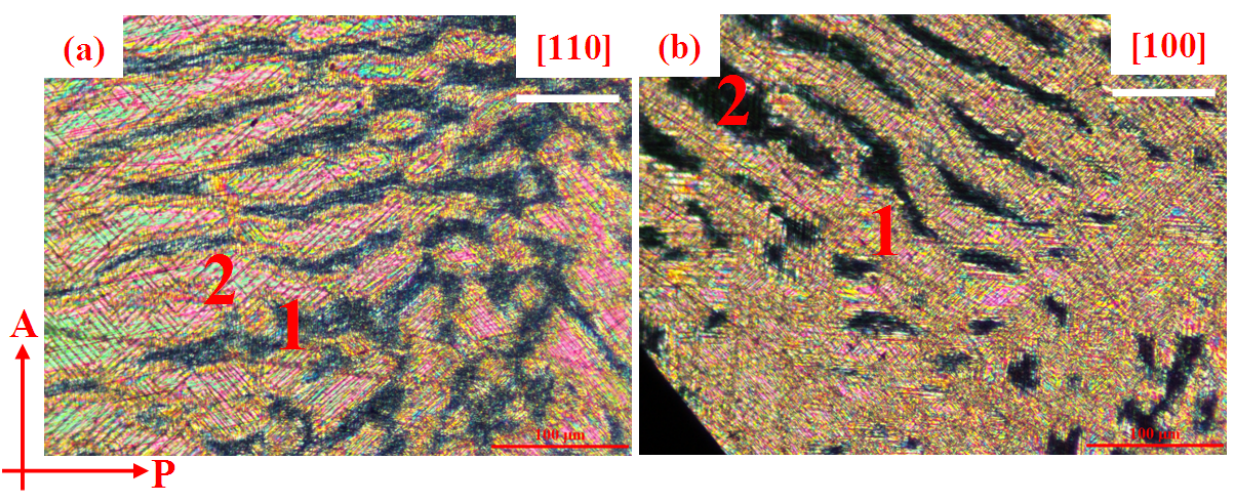
Figure 6. Domain structure of [001]-oriented KNN-LT single crystals, ( a ) [110] and ( b ) [100] parallel to